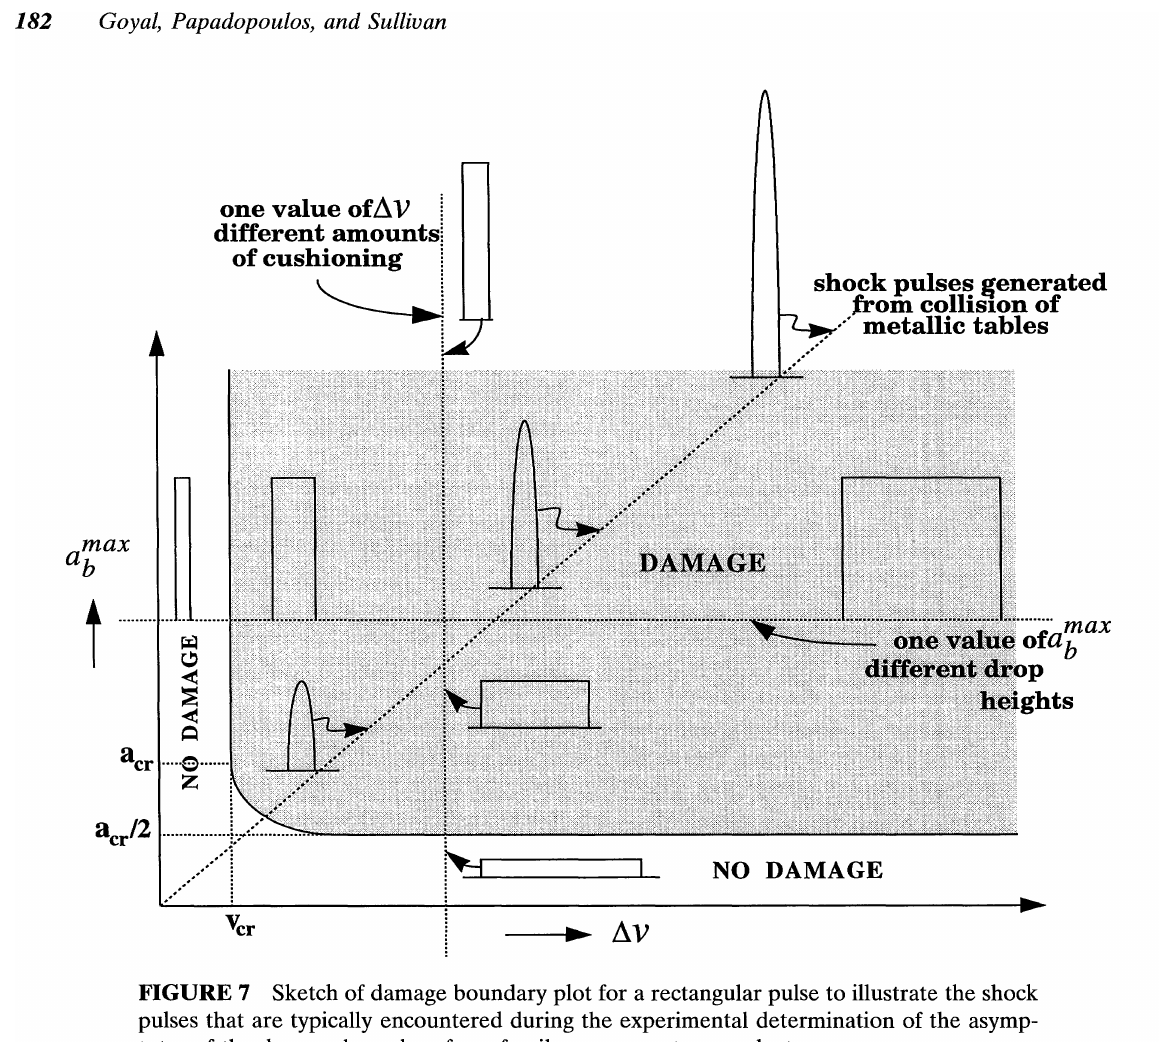
FIGURE 7 Sketch of damage boundary plot for a rectangular pulse to illustrate the shock pulses that are typically encountered during the experimental determination of the asymp totes of the damage boundary for a fragile component or